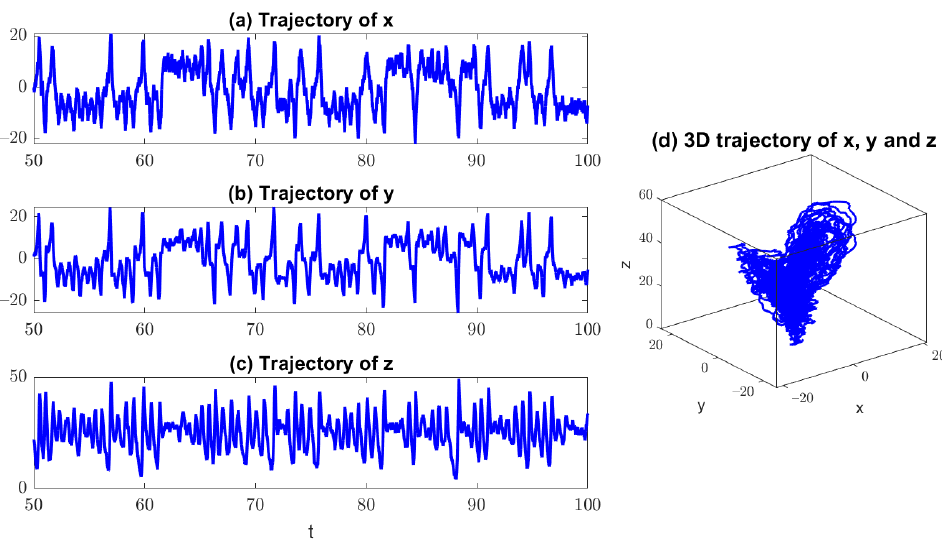
Figure 1. The noisy Lorenz 63 model (12) with parameters in (13). ( a – c ) one realization of the one- dimensional trajectories of x , y , and z , respectively; ( d ) the associated three-dimensional phase plot of ( x , y , z )